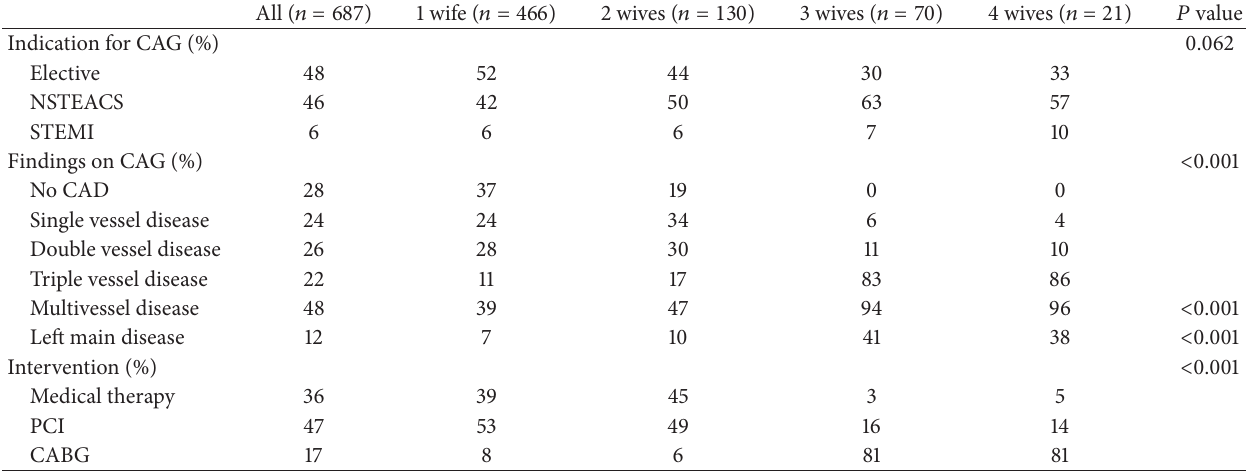
Table 2: Coronary angiogram findings stratified by their number of wives.